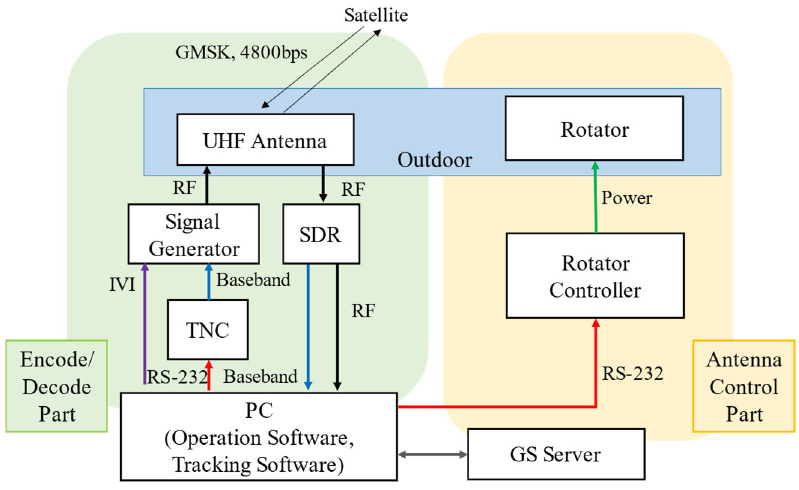
Figure 22. Configuration of ground station at